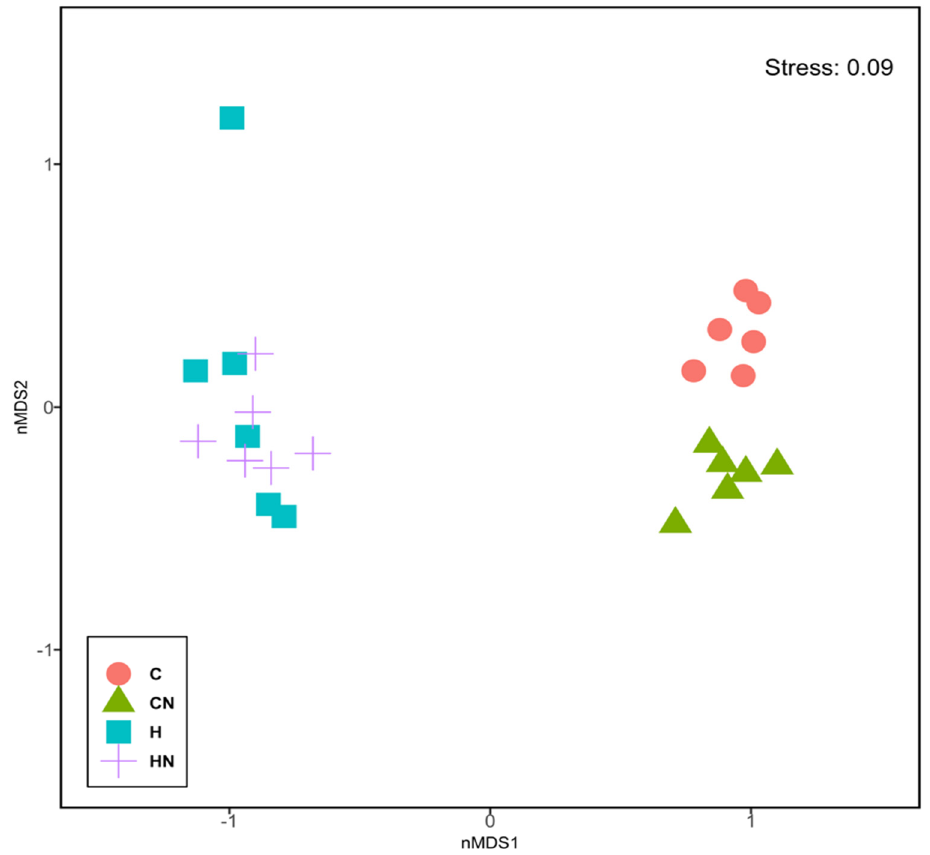
Figure 4. Non-metric multi-dimensional scaling plot of bacterial gut communities. C, rats fed with corn starch diet; CN, rats fed with corn starch diet + Nannochloropsis oceanica ; H, rats fed with high- carbohydrate, high-fat diet; HN, rats fed with high-carbohydrate, high-fat diet + Nannochloropsis oceanica .